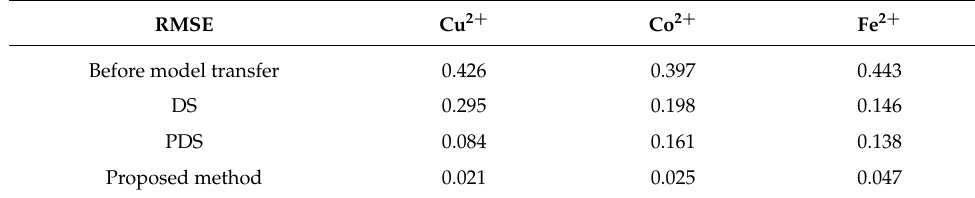
Table 2. Comparison of transfer performance of three model transfer algorithms of the test